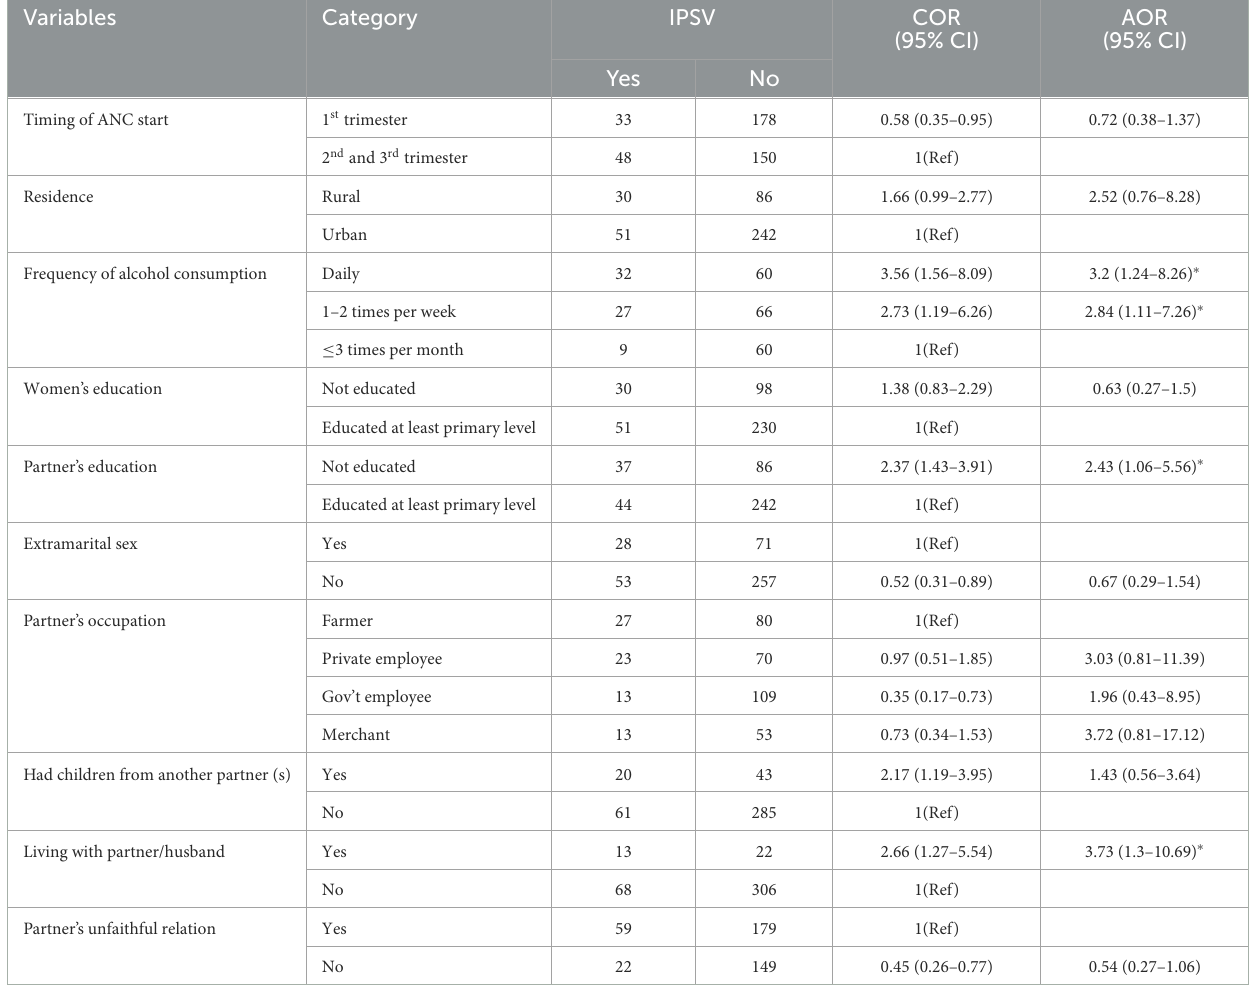
TABLE 4 Bivariable and Multivariable analysis of factors associated with IPSV among pregnant women in Debre Markos town, Northwest, Ethiopia ( n = 409).